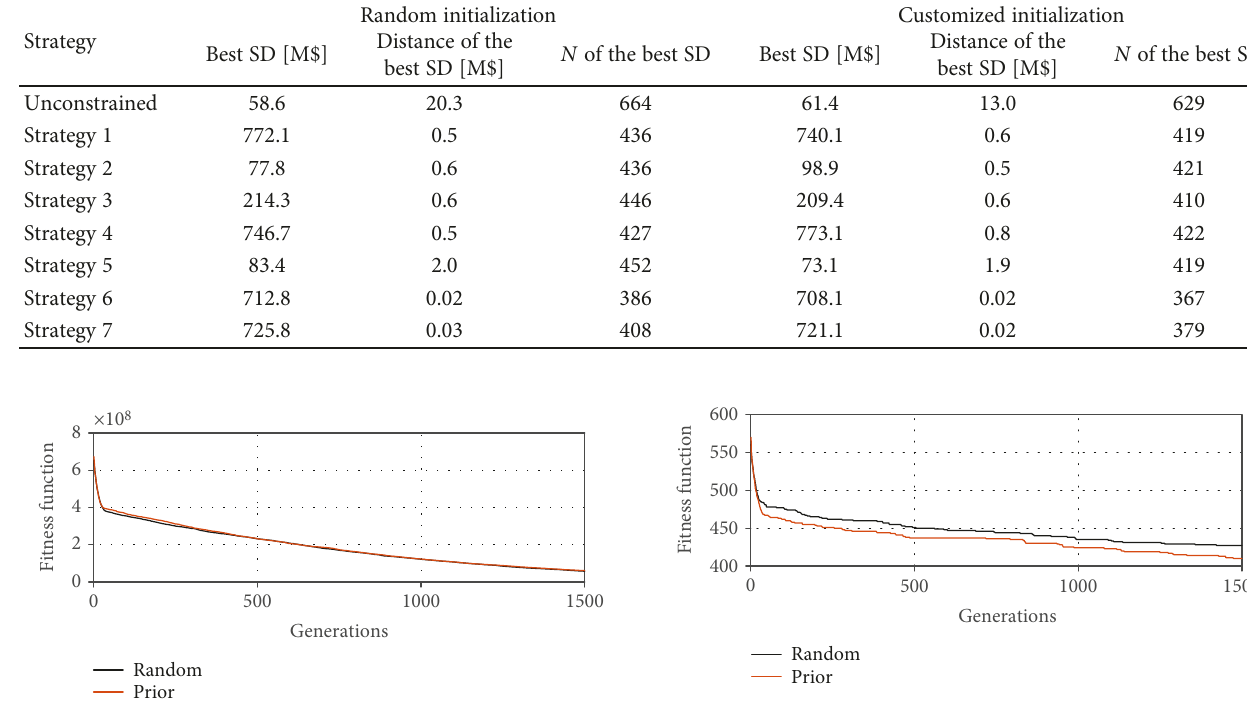
Figure 10: ff harmonic evolution of the fi tness function of strategy 3 through generations.